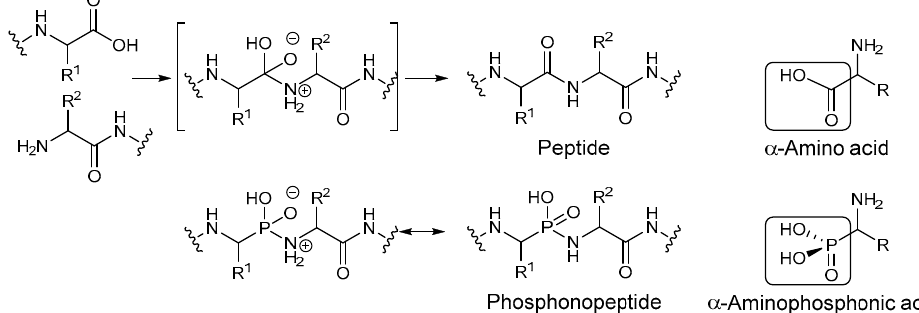
Figure 1. α‐ Aminophosphonic acid group mimics the transition state of peptide cleavage.